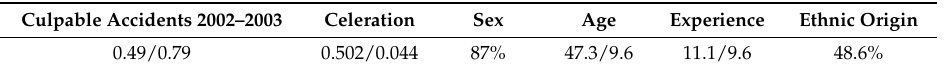
Table 1. The means and standard deviations (where applicable) of accidents and the predictor variables; celeration (m/s 2 ), sex (percent men), age (years), experience (years of employment at Gamla Uppsalabuss (GUB)), and ethnic origin (percent drivers with Swedish names). N =